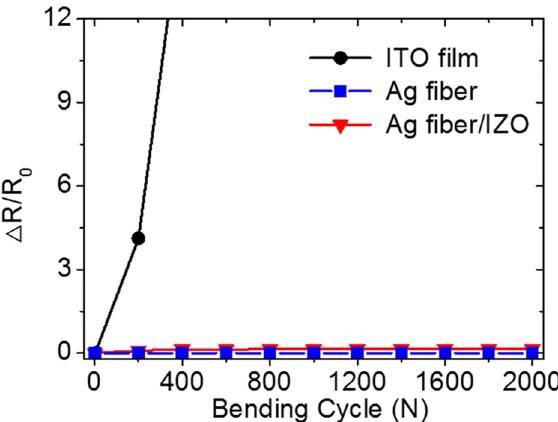
Figure 4. Resistance changes in the cyclic bending test [35].